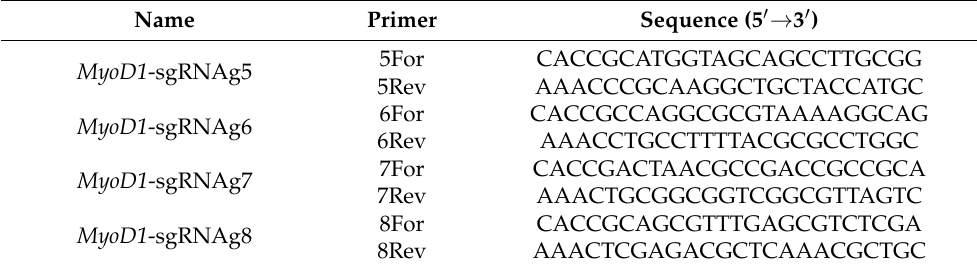
Table 1. The primer sequence of MyoD1